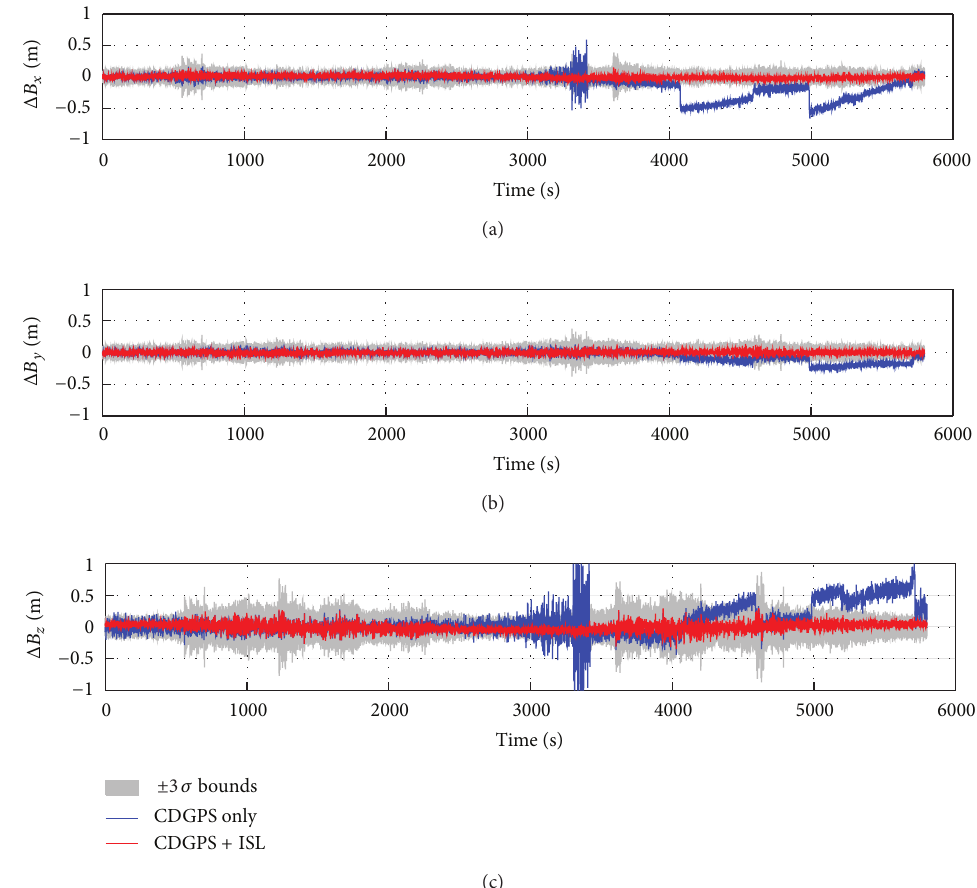
Figure 7: ORF baseline component errors (the second case); ±3𝜎 bounds are relevant to CDGPS +